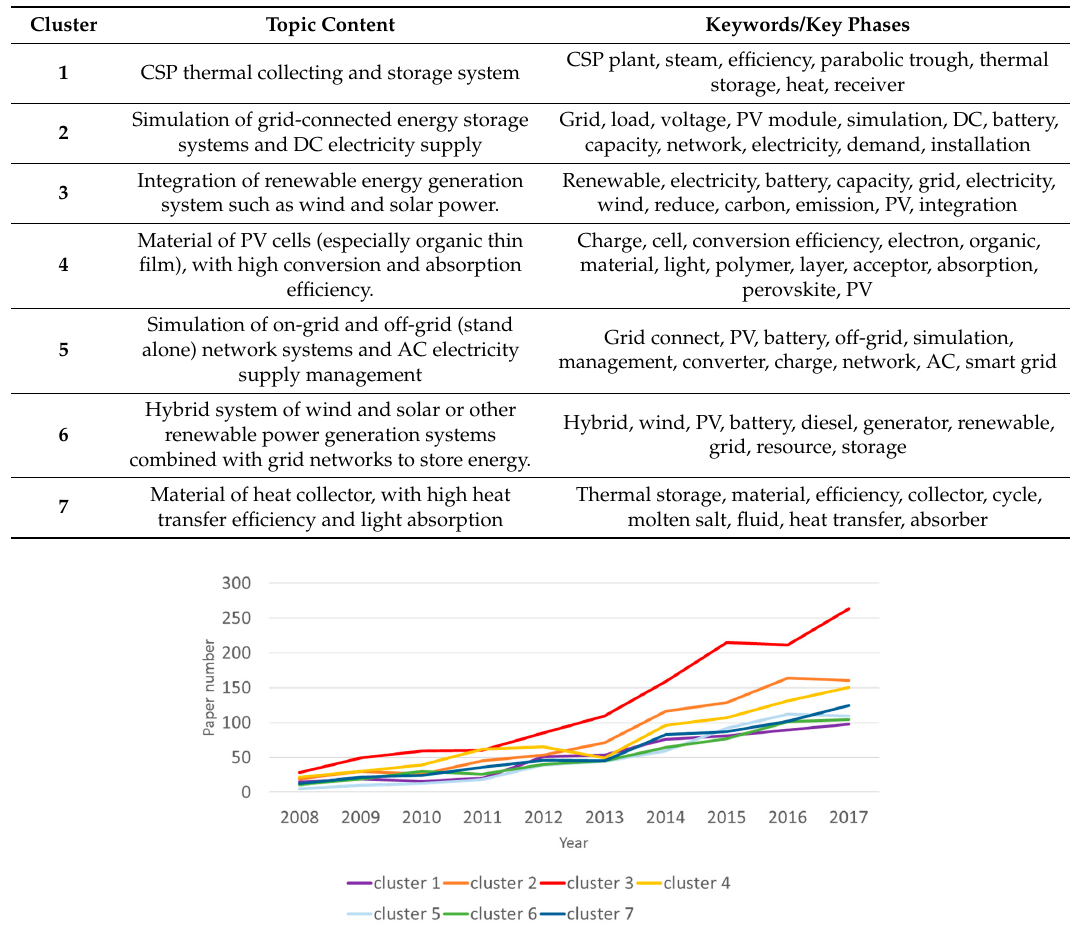
Table 3. Description of literature clusters.